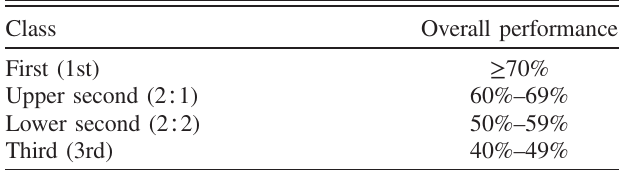
TABLE II. Classification of honor ’ s